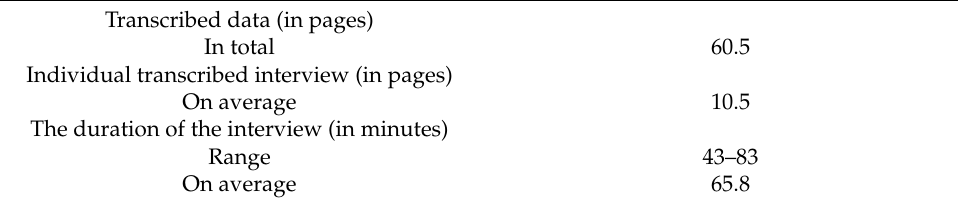
Table 2. Original data